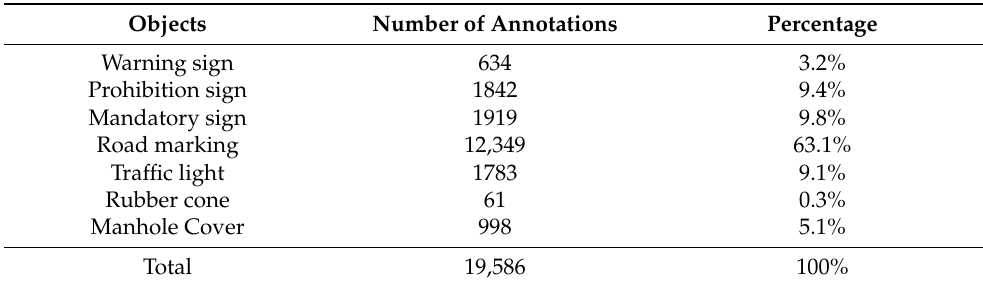
Table 3. Testbed ground truth.